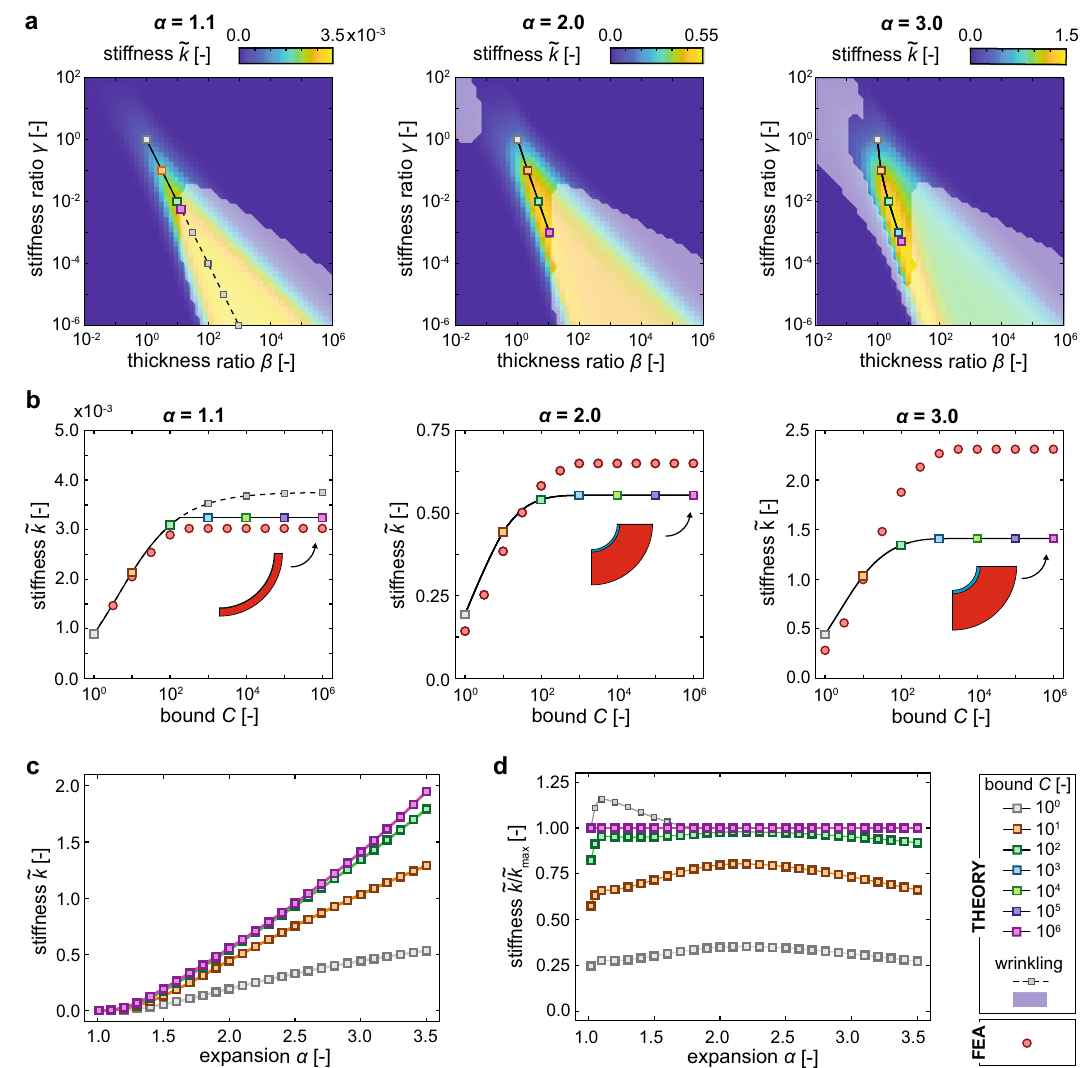
Fig. 5 Combined bending and stiffness analysis. a Theoretical normalized stiffness values for different combinations of thickness ratio, β , and stiffness ratio, γ . b The maximum theoretical stiffness subjected to different limits for β and γ . c The maximum normalized stiffness for different bounds C as a function of the expansion ratio, α . d The maximum normalized stiffness normalized by the stiffness values with C = 10 6